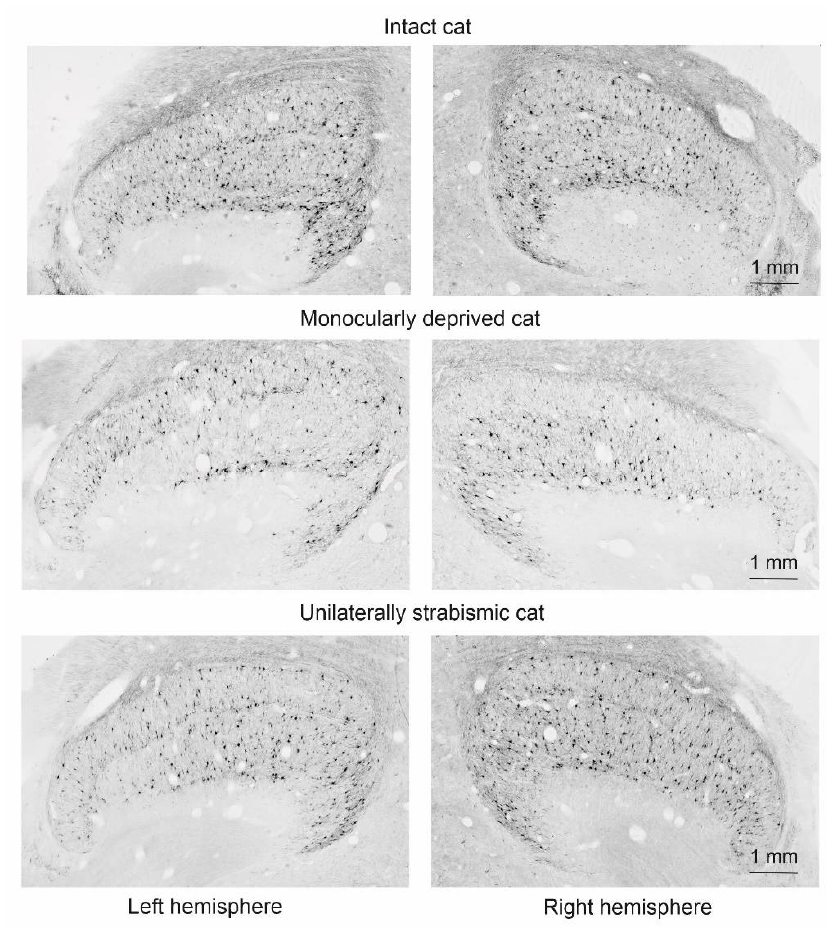
Figure 2. The images of the histological sections of the LGN of the right and left hemispheres in intact monocularly deprived and unilaterally strabismic kittens aged 60 days.